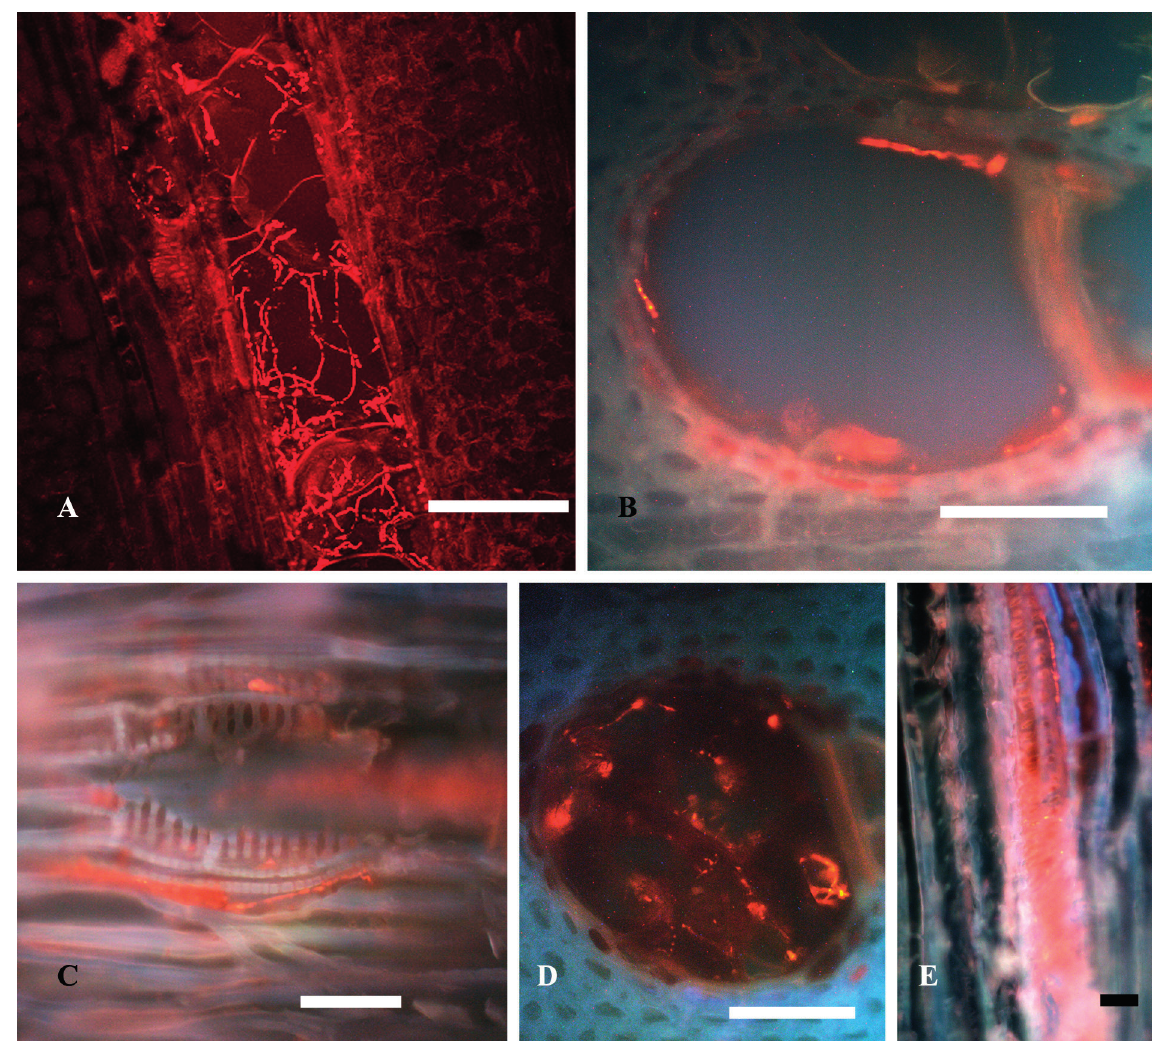
Figure 1. Growth of Phaeomoniella chlamydospora expressing the DsRed fluorescent protein in grapevine wood tis - sue after inoculation of one-year-old canes of Cabernet Sauvignon and Sauvignon blanc. A. Longitudinal section (l.s) of xylem vessel with an extensive mycelium growth in the lumen, 90 days after inoculation. B. Transverse section of xylem vessel with hyphae growing adhering to the vessel walls. C. Hyphae growing in intercellular space (l.s). D and E. Transverse (D) and longitudinal (E) sections of hyphae growing in xylem vessels occluded with gels. Scale bars for A, 100 µ m; B–E, 50 µ